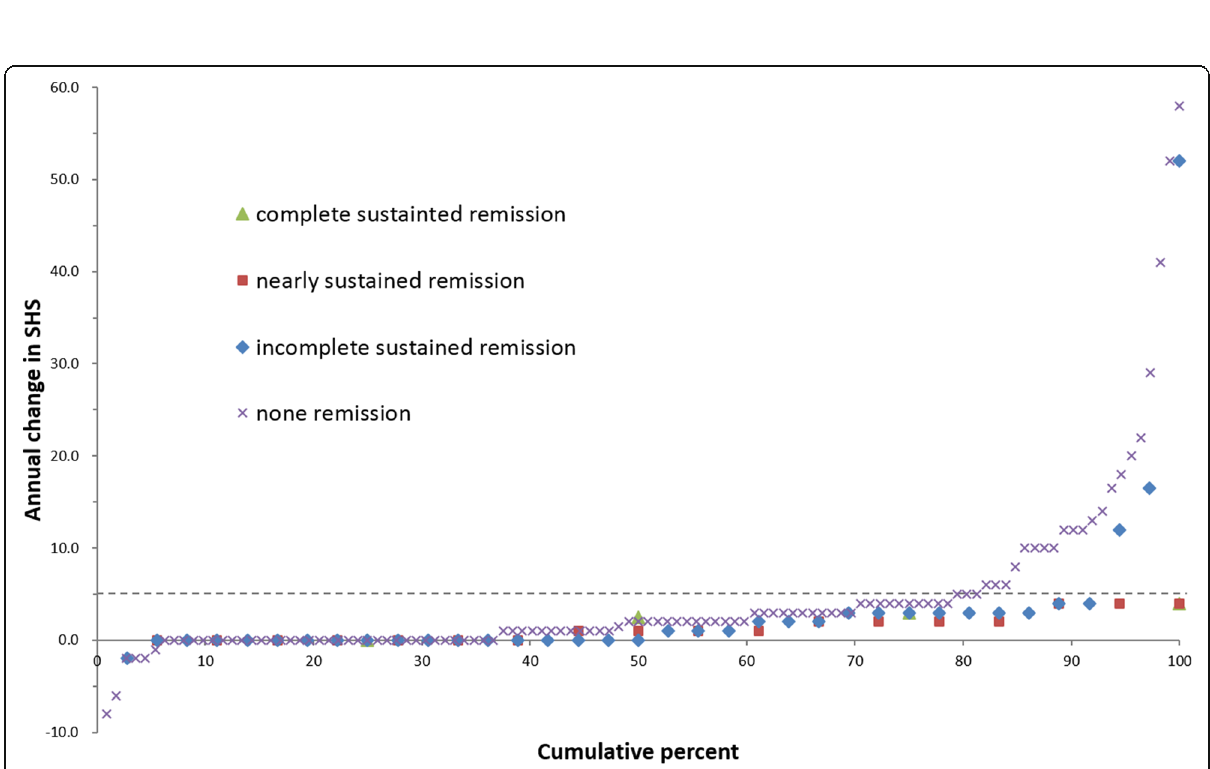
Fig. 4 Cumulative probability plot for patients in sustained remission according to Boolean based remission criterion during follow-up